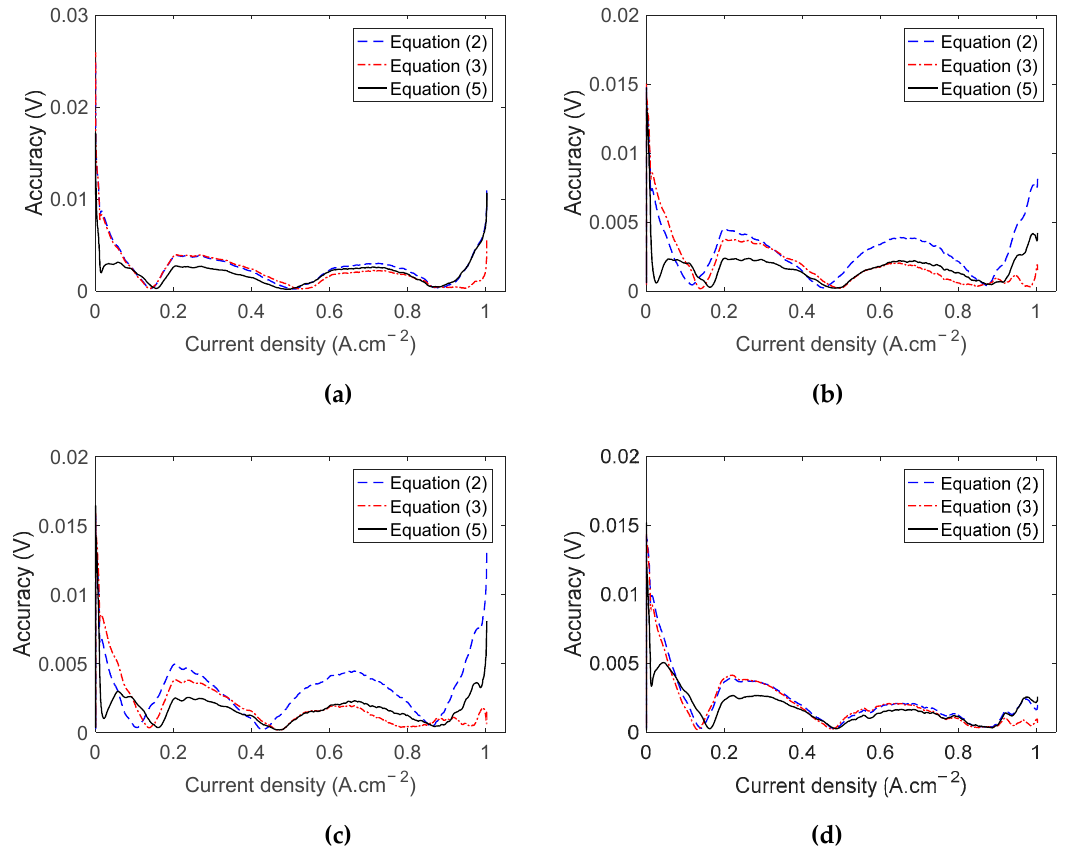
Figure 3. Simulation accuracy of three V-I models at different current densities collected at ( a ) 48 h; ( b ) 348 h; ( c ) 658 h; ( d ) 991 h. Table 3. Mean fitting accuracy of three terms in V-I curve using different models.